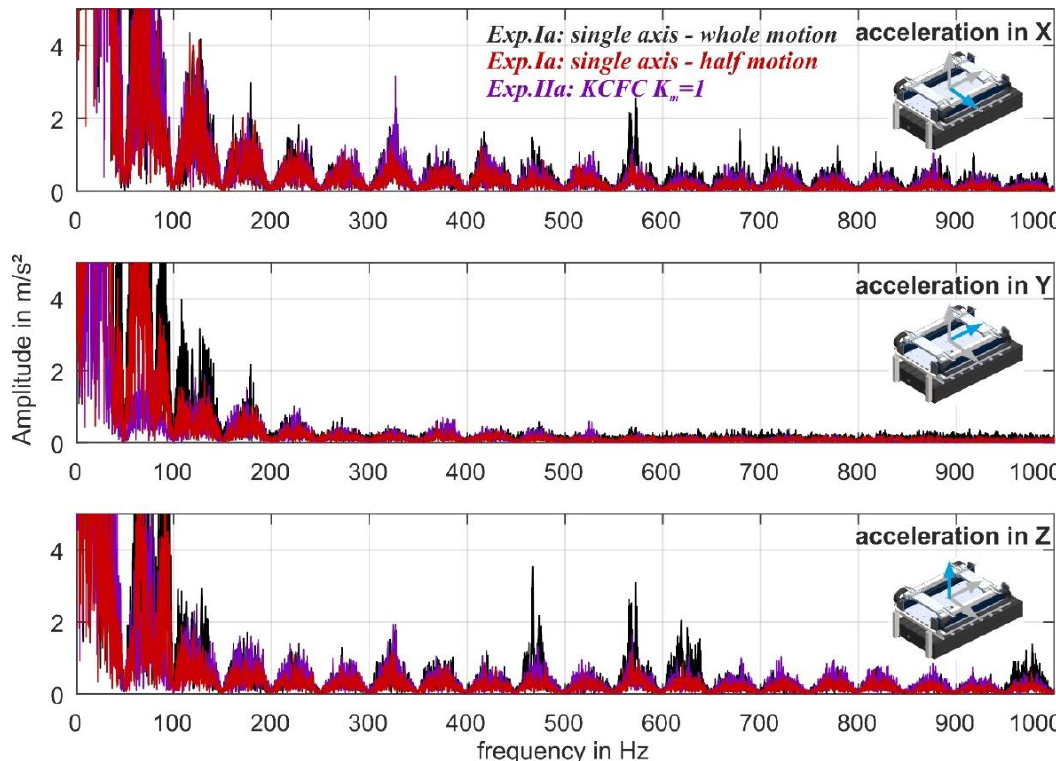
Figure 4. Frequency response of the measured acceleration – time-profiles (compare Figure 3).